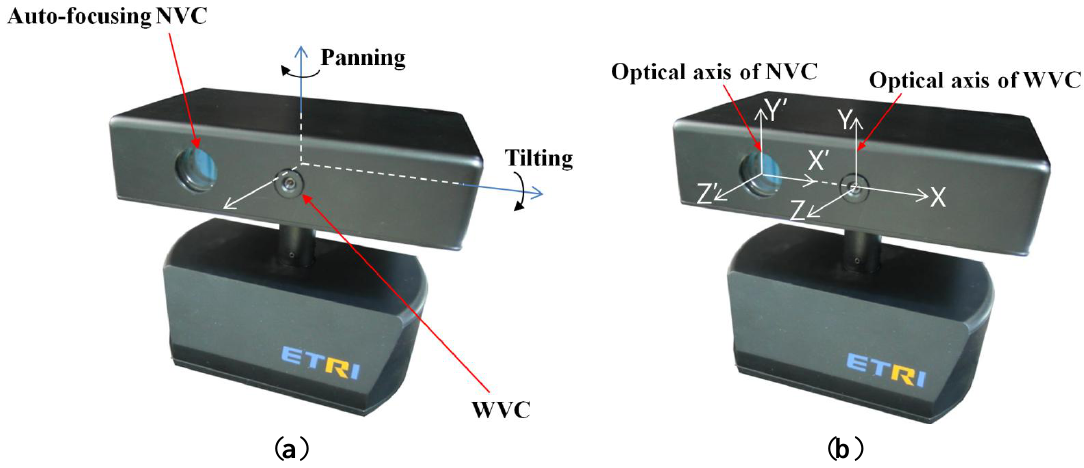
Figure 3. Proposed gaze tracking device. ( a ) Panning and tilting structures. ( b ) Parallel structure of the NVC and